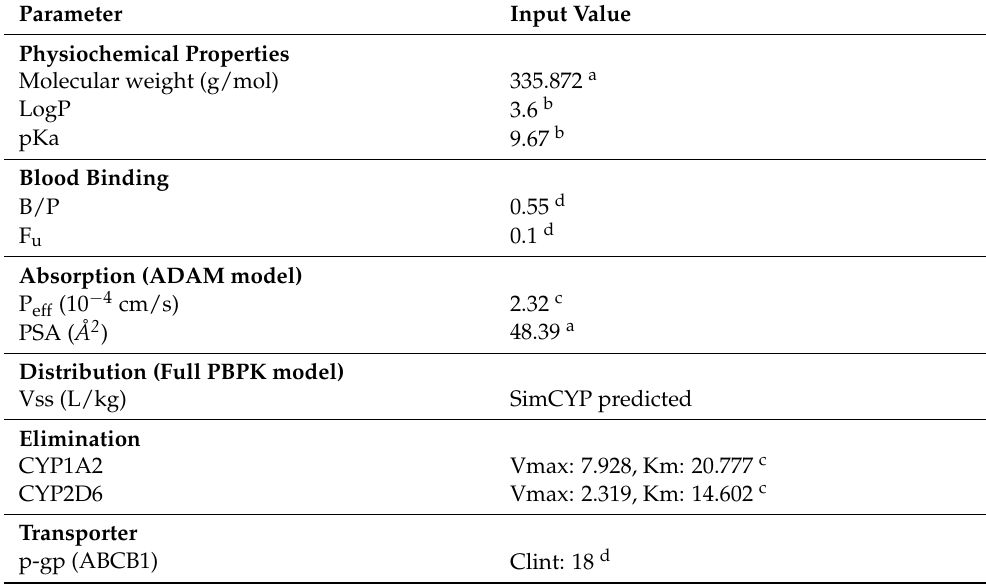
Table 1. Input parameters for HCQ PBPK model. B/P: blood-to-plasma partition ratio. F u : the fraction of unbound drug in plasma. P eff : human jejunum effective permeability. PSA: polar surface area. V ss : volume of distribution at steady state using tissue volumes for a population representative of healthy volunteer population. Vmax: maximum rate of metabolism (pmol/min/pmol of isoform). Km: Michaelis-Menten constant, ( µ M). a: data from DrugBank. b: data from Pubmed. c: